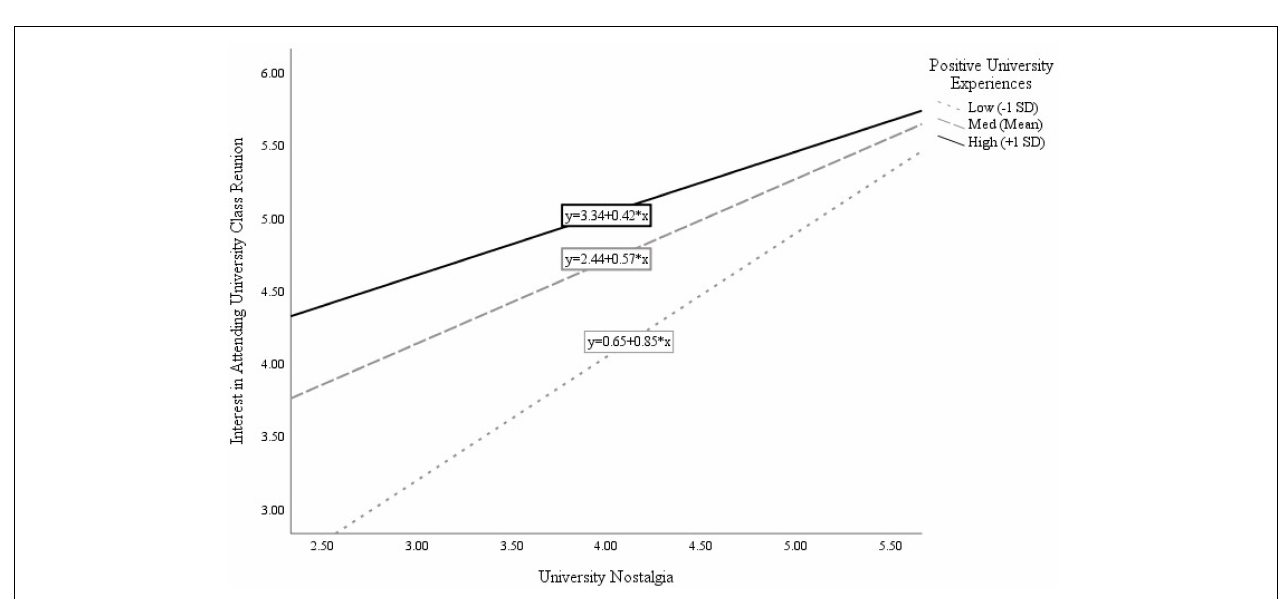
FIGURE 2 | Moderation of relation between University Nostalgia and reunion interest by positive University